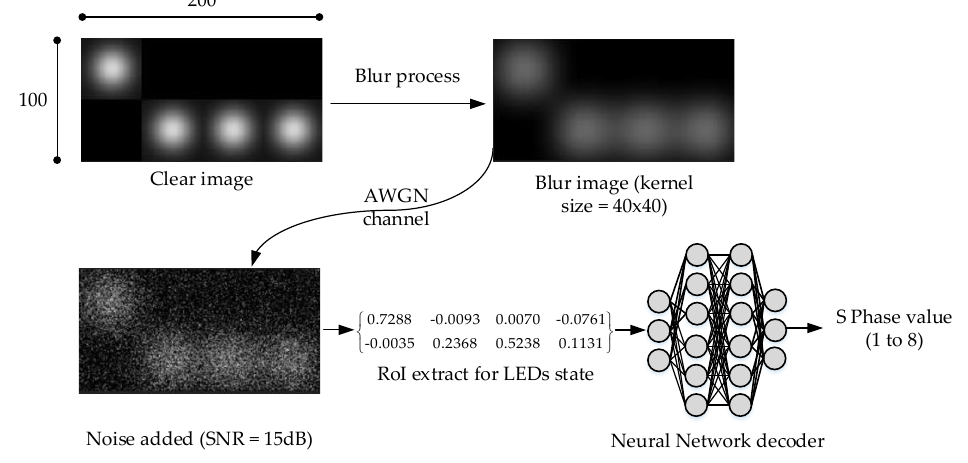
Figure 8. Illustration of data augmentation with the blur process and noisy channel for neural network-based decoder training and performance evaluation.